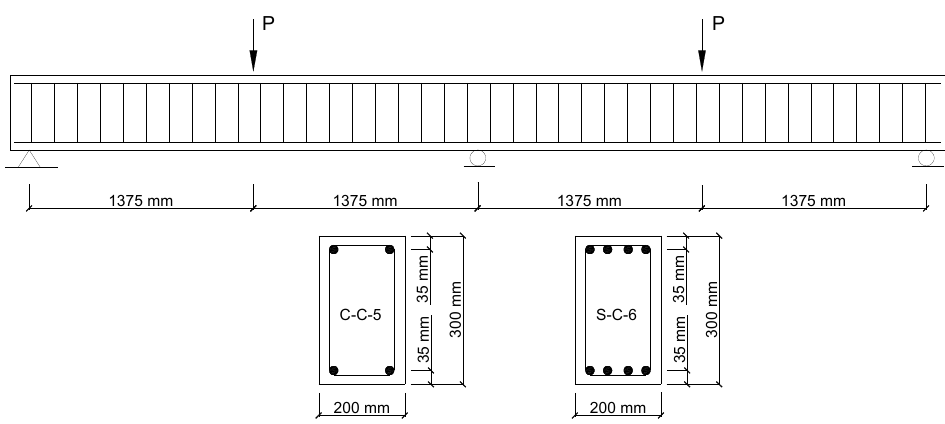
Figure 1. Two-span RC test beams (schematic diagram).